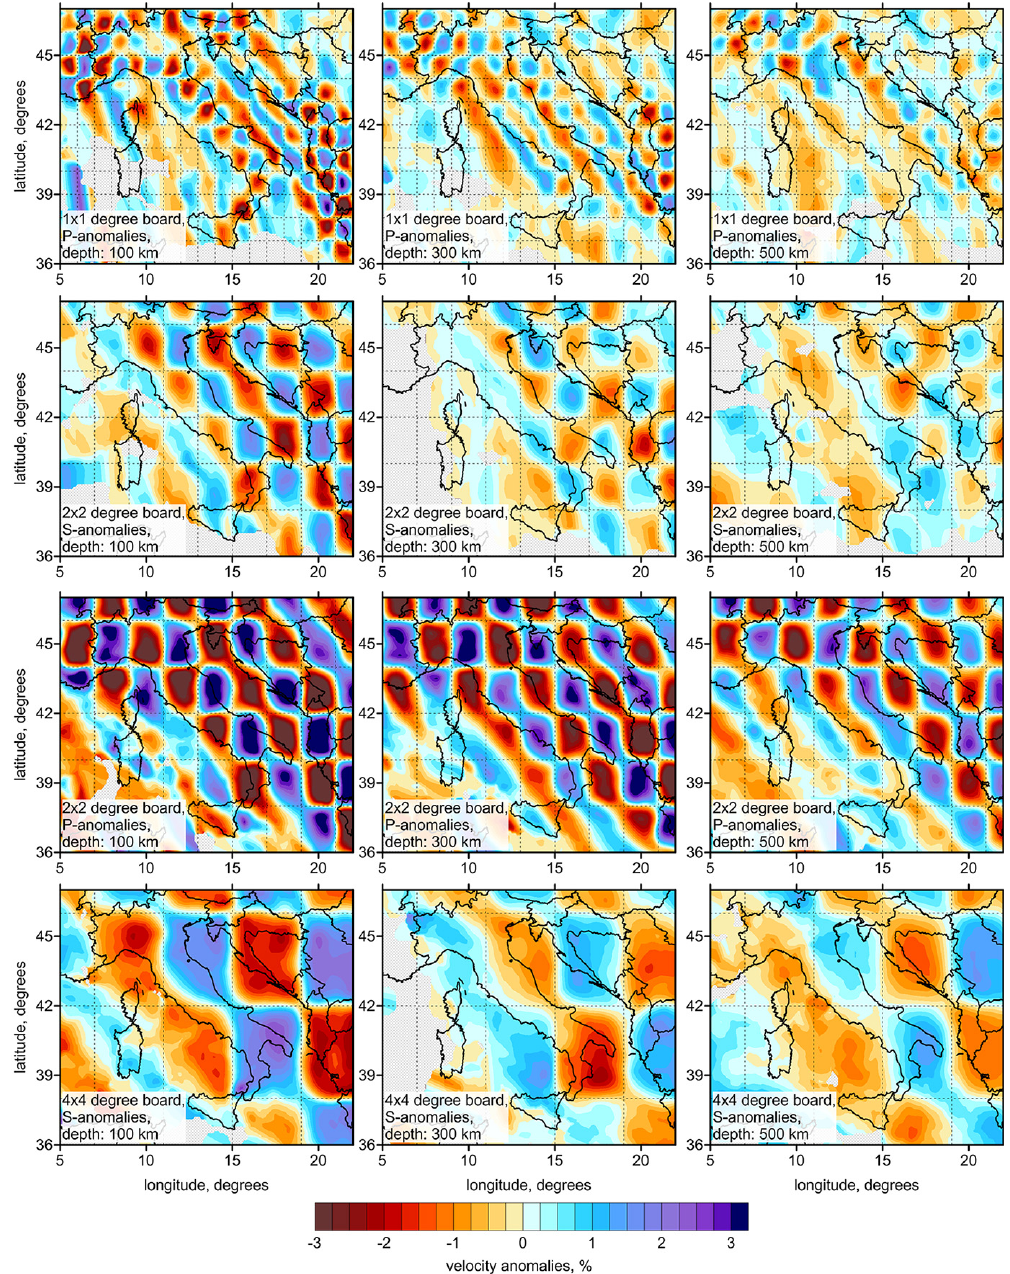
Figure 6. Checkerboard tests for two different P and S velocity models. In all cases, the signs of anomalies change at 200, 400, 600km etc. Dotted lines mark boundaries of the synthetic